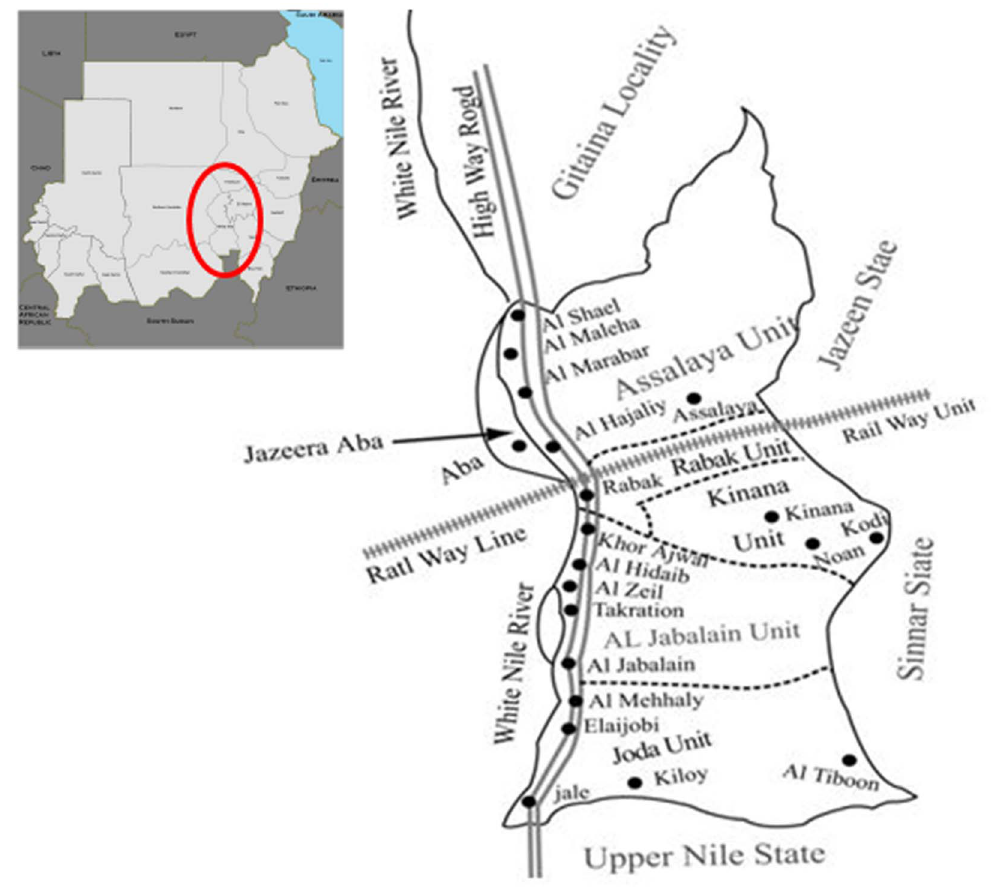
N ); baseline survey areas of each unit in the Al